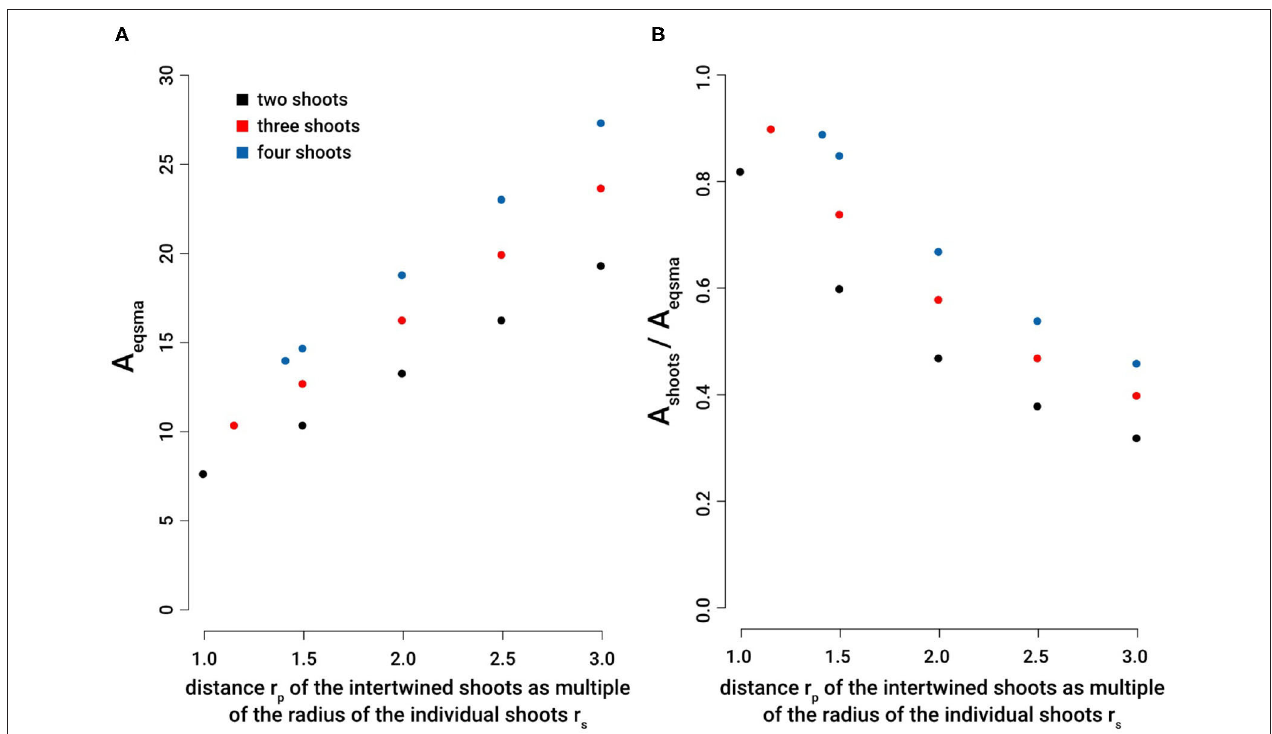
FIGURE 8 | Efficiency of intertwining stems: Comparison of the cross sectional area of an individual stem required to reach the second moment of area equivalent to two, three, or four intertwined stems with various distances from the centroid of the braid structure. (A) A eqsma : cross-sectional area equal to the second moment of area of an individual shoot necessary to reach the same axial second moment of area of 2, 3, or 4 intertwined stems, each with a constant cross-sectional area of A individualshoot = 3.14. (B) A shoots /A eqsma : ratio of cross-sectional areas comparing the cross-sectional area of 2, 3 and 4 intertwined shoots with the cross-sectional areas of equal second moment of area of an individual single shoot. The distance of intertwined stems is given by r p as multiples of the radius of individual stems r s : r p = r s [or r p = 1.155 r s (for n = 3) and r p = 1.414 r s (for n = 4), respectively], r p = 1.5 r s , r p = 2 r s , r p = 2.5 r s , and r p = 3 r s